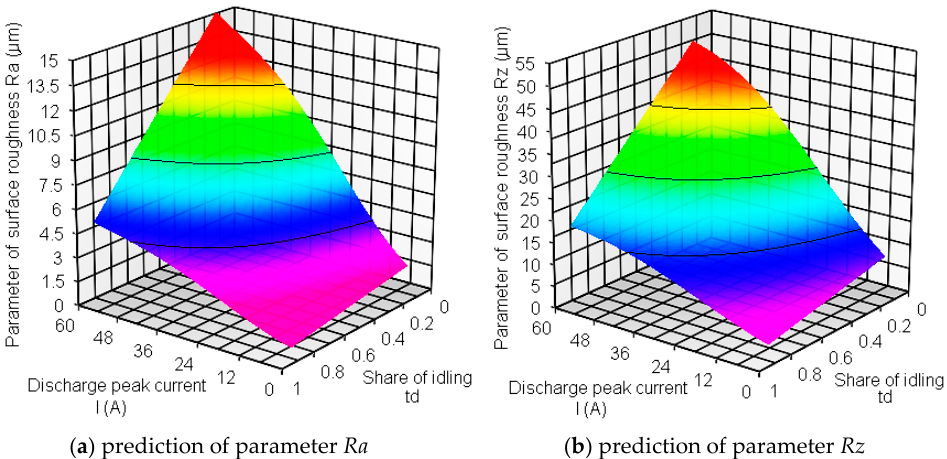
Figure 13. Graphical representation of prediction of the surface roughness parameters Ra and Rz of tool steel EN X32CrMoV12 ‐ 28 in dependence of significant technological parameters I , t on and t off at die ‐ sinking EDM with a SF ‐ Cu electrode.